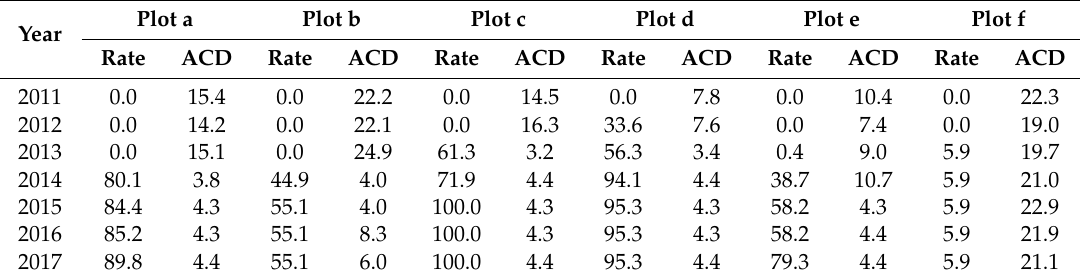
Table 8. Annual aboveground carbon density (ACD) dynamics caused by di ff erent deforestation rates from estimates using MODIS data based on the best